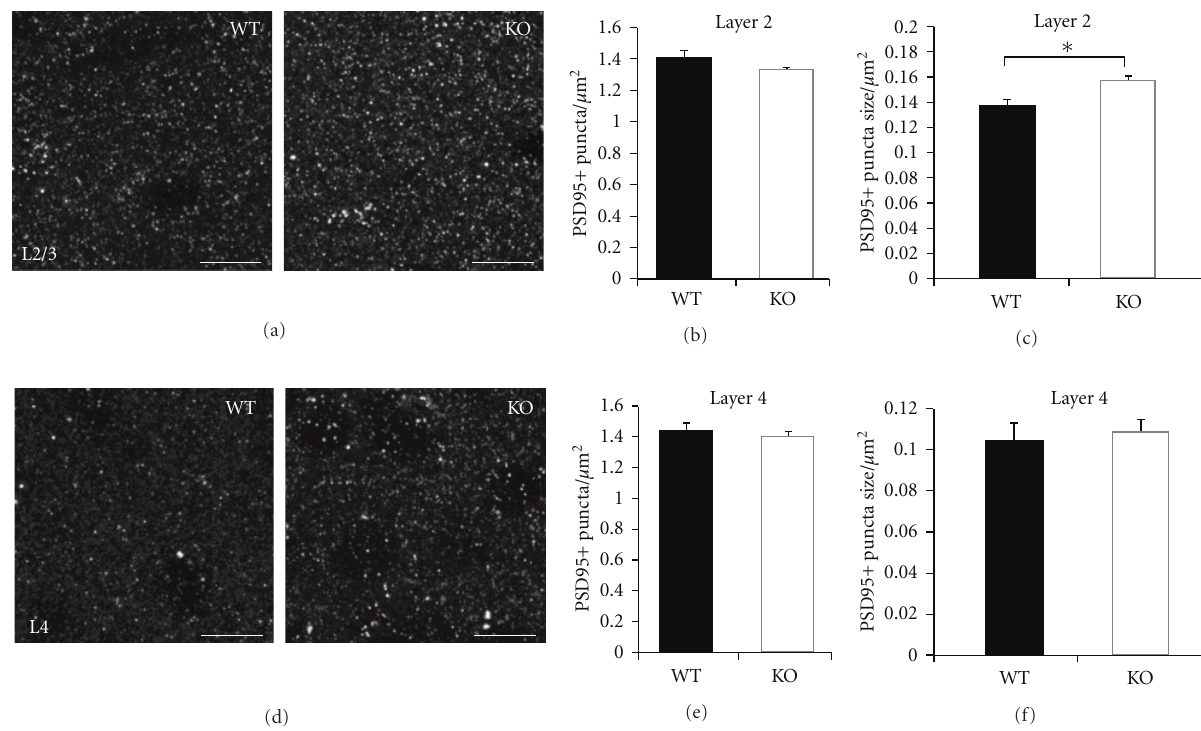
Figure 5: Immunohistochemical analysis of excitatory synapses in wildtype and prestin KO animals. (a) Labeling of puncta positive for the excitatory marker PSD-95 in layer 2/3 of A1. (b) Density of PSD-95+ puncta did not di ff er significantly between WT ( n = 3) and KO ( n = 3) mice in L2/3 of A1 ( P > . 05). (c) The size of PSD-95+ puncta is significantly greater in KO versus WT in L2/3 of A1 ( P = . 015). (d) PSD-95+ puncta in layer 4 of A1. (e) Density of PSD-95+ puncta did not di ff er significantly between WT ( n = 3) and KO ( n = 3) mice in L4 of A1 ( P > . 05). (f) The size of PSD-95+ puncta did not di ff er significantly between WT and KO mice in L4 of A1 ( P > . 05). Scale bars: 10 μ m.